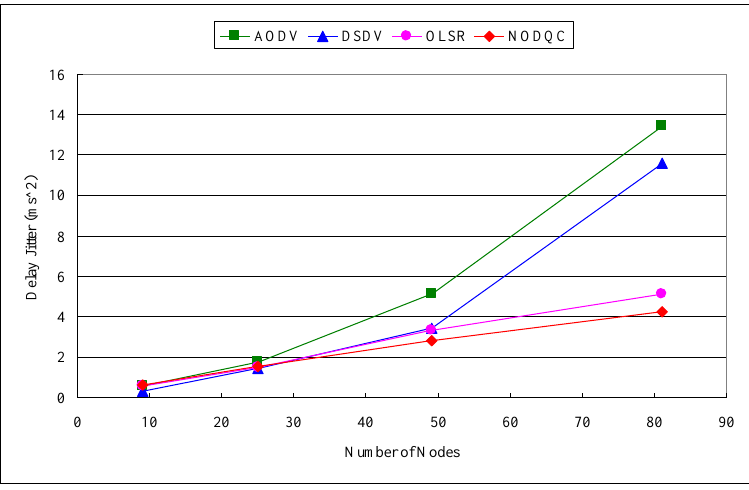
Figure 7. Experiment results of routing algorithms (delay jitter).